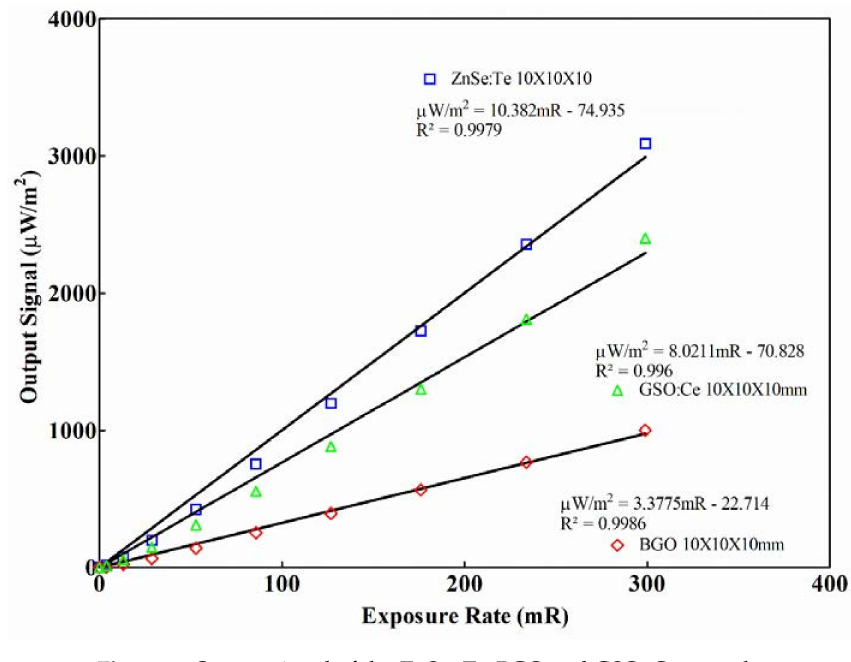
Figure 8. Output signal of the ZnSe: Te, BGO and GSO: Ce crystals.